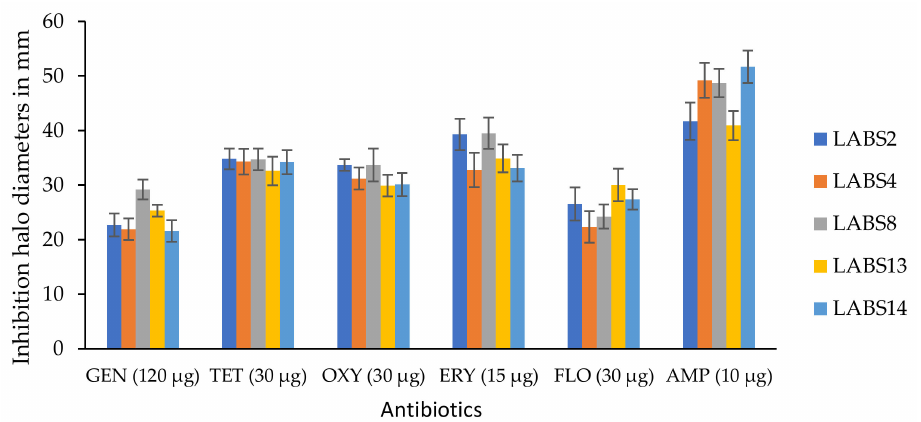
Figure 1. Antibiotic susceptibility of the 5 LAB strains (LABS2, LABS4, LABS8, LABS13 and LABS14), obtained from the intestinal content of rainbow trout to the antibacterial gentamycin (GEN), tetra- cycline (TET), oxytetracycline (OXY), erythromycin (ERY), florfenicol (FLO), and ampicillin (AMP), evaluated by the disc diffusion antibiotic method according to CLSI (2022) [59]. Data is given as mean ± SD. Experiments were carried out in